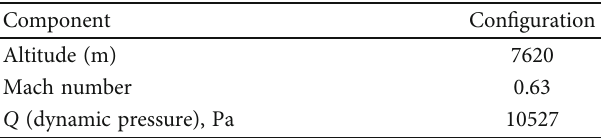
Table 1: Uniform fl ow fi eld.